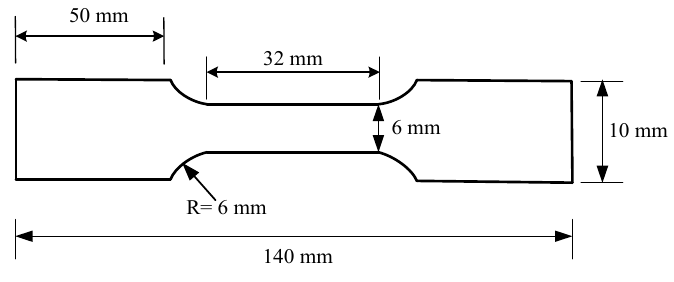
Figure 2. Tensile test specimen dimension.